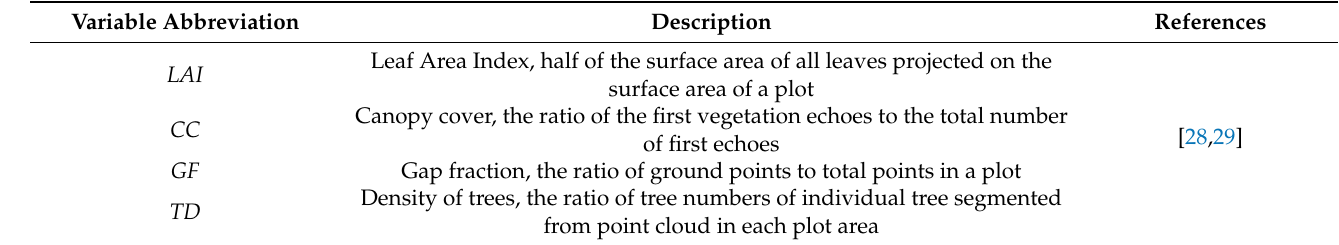
Table 6. Forest stand